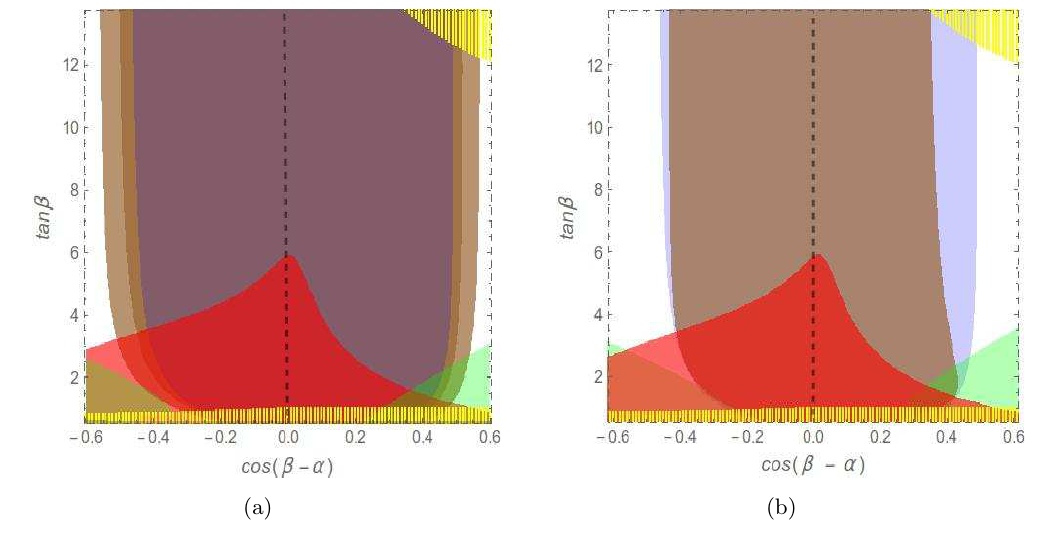
Figure 1 . The effect of ϕ 4 D 2 type of operators for Type-I 2HDM: (a) BP1, (b) BP2, as described in the text. Blue and brown regions indicate areas allowed from the measurement of the signal strengths of SM-like Higgs boson, in 2HDM at tree-level and in presence of 6-dim operators re- spectively. For (a), lighter and darker brown region represent BP1 with f = 1 TeV and 2 TeV respectively. The yellow shadowed region is ruled out by theoretical criteria such as perturbativity, stability, unitarity of the S-matrix. The green and red regions are ruled out from non-observation of A Zh ( b ¯ b ) and A ZH ( b ¯ b ) respectively including the effects of 6-dim operators for f = 1 TeV → → for both BP1 and